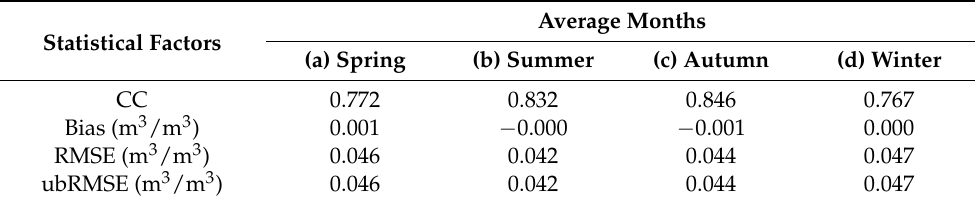
Table 6. Statistical comparison results between GLDAS and GK-2A